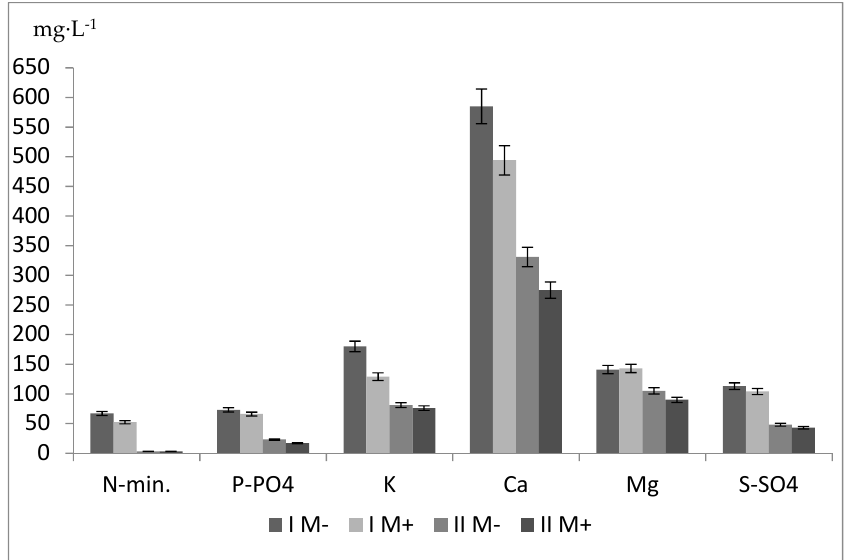
Figure 4. Concentration of N-min., P, K, Ca, Mg S-SO 4 (mg · L − 1 ) dependent of micorrhization and analysis term in azalea substrate. Average from years. I = first decade of August; II = third decade of October; without ERM (M-) = nonmycorrhizal plants; with ERM (M+) = mycorrhizal